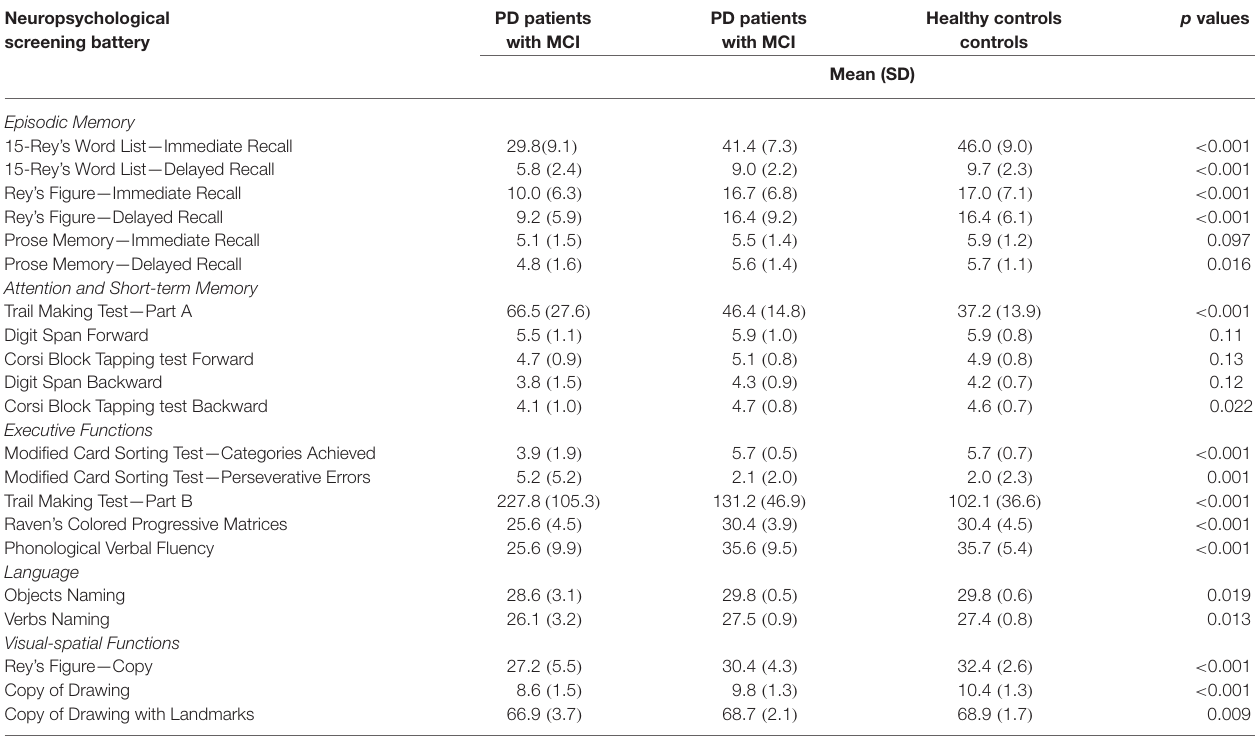
TABLE 2 | Average scores obtained by subjects of the three experimental groups with results of univariate ANOVAs are reported .